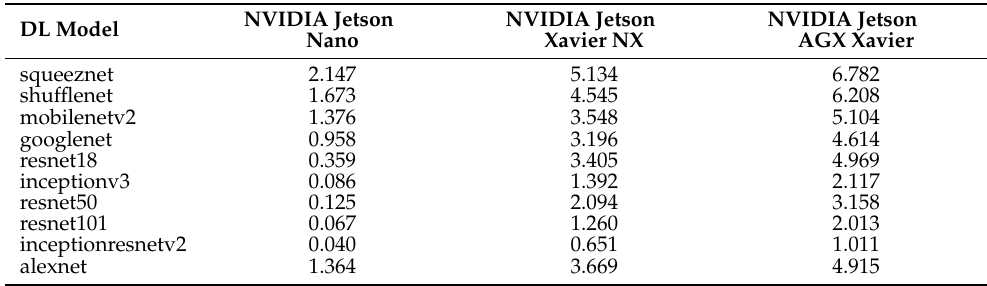
Table 6. Runtime performance ( mFPS ) evaluation depending on embedded hardware platforms. DL